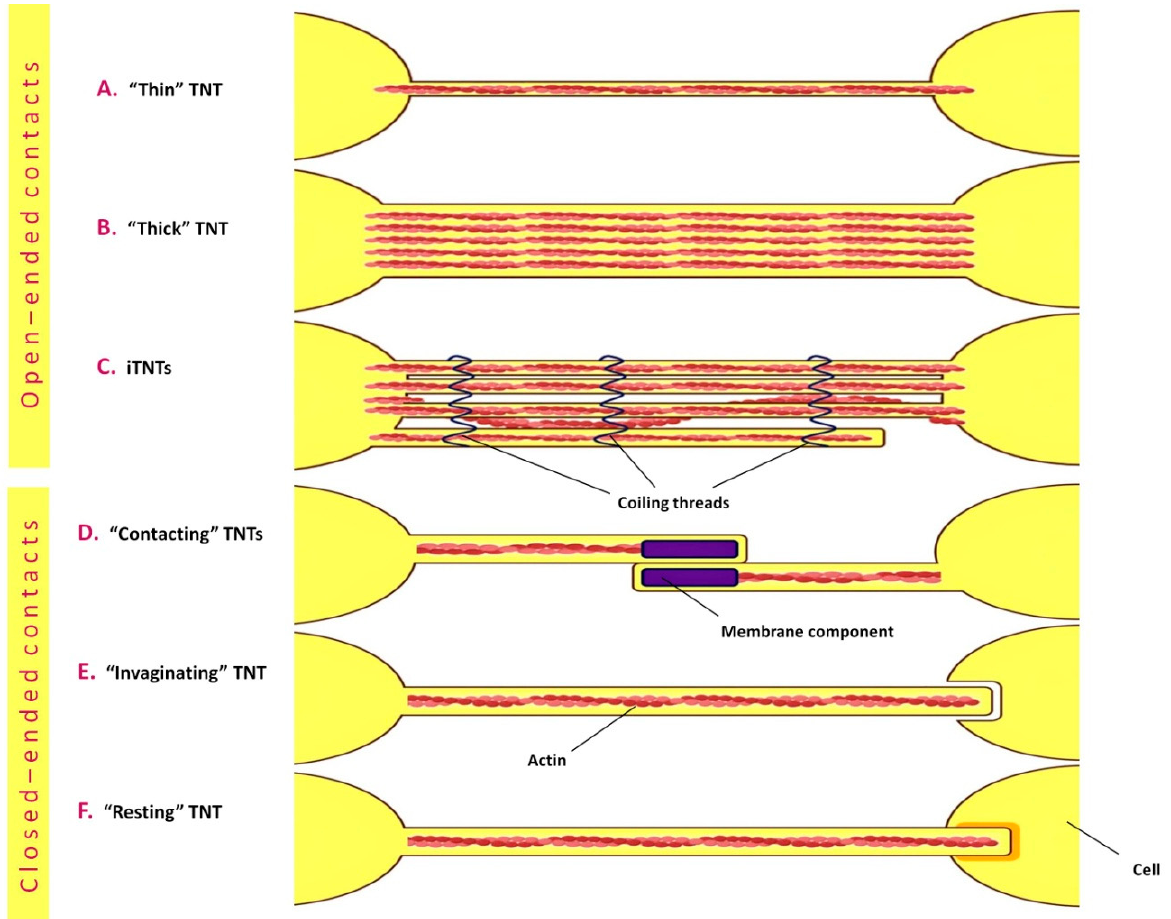
Figure 4. Types of tunneling nanotubes with open- and closed-ended contacts. Electron microscopy studies demonstrate that tunnelling nanotubes are quite dynamic structures that can belong both to the open-ended ( A – C ) and closed-ended ( D – F ) membrane protrusions. Scanning electron microscopy (SEM) and cryo-transmissive electron microscopy (cryo-TEM) revealed the existence of thin ( A ) and thick ( B ) TNTs. Thick TNTs are usually large in diameter but may also be represented by bundles consisting of individual tunneling nanotubes (iTNTs) that are mostly parallel to each other but sometimes may be intertwined. These individual TNTs are connected, in addition to the cell adhesion molecule N-cadherin, by coiling threads around iTNTs ( C ). Closed-ended types of TNTs presumably promote intercellular interaction through gap junctions. Serial-sectioning transmissive electron microscopy (ssTEM) revealed two closed-ended TNT types in immune cells, namely, a TNT type with two protrusions that contact in the middle, with membrane components located at the contacting tips ( D ), and single TNTs invaginating into the opposite cell ( E ). Focused ion beam scanning electron microscopy (FIB SEM) revealed the resting form of closed-ended TNTs ( F